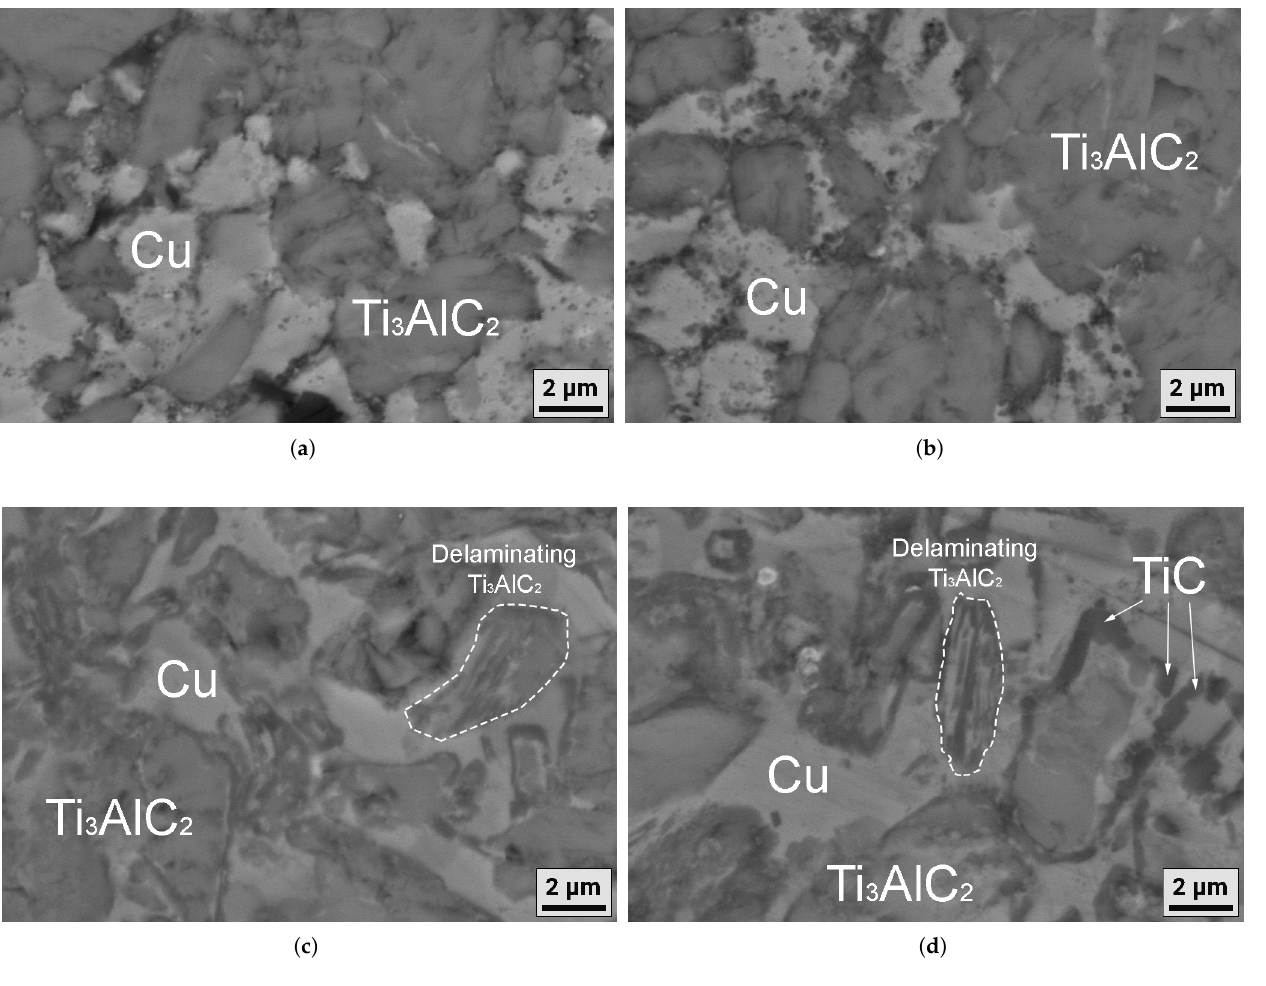
Figure 1. SEM pictures of Ti 3 AlC 2 : Cu (1:1) cross-sections after sintering at 800 ( a ); 900 ( b ); 1000 ( c ); and 1050 ( d ) °C in